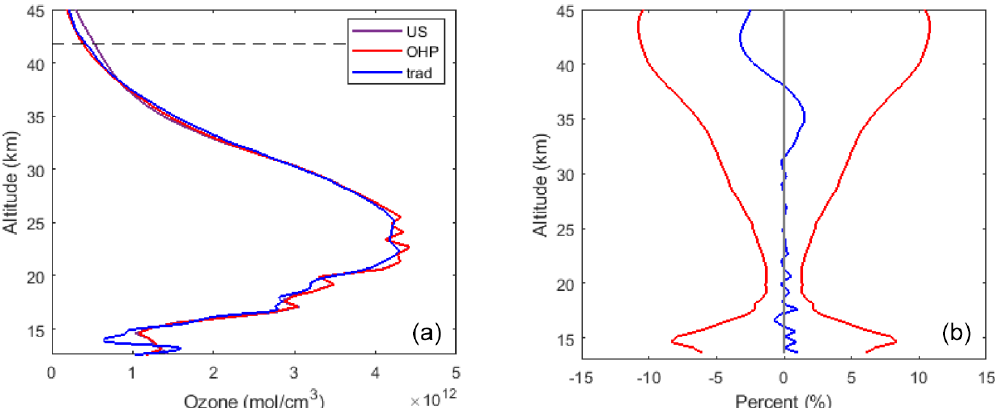
Figure 10. For the night of 26 July 2017. (a) the OEM retrieval using the US standard model as an a priori profile (purple curve) and the OEM retrieval using the OHP climatology as an a priori profile (red curve) are plotted. Furthermore, the traditional method retrieval (blue curve) is plotted, and thus the OEM retrievals can be compared with each other and with the traditional retrieval. (b) Percentage difference between the OEM retrievals using the two different a priori profiles (blue curve) is plotted. This difference is within the retrieval uncertainty. At higher altitudes (above 35km) when the SNR drops, the difference between the two methods is less than 5%, which is smaller than the retrieval uncertainty at that